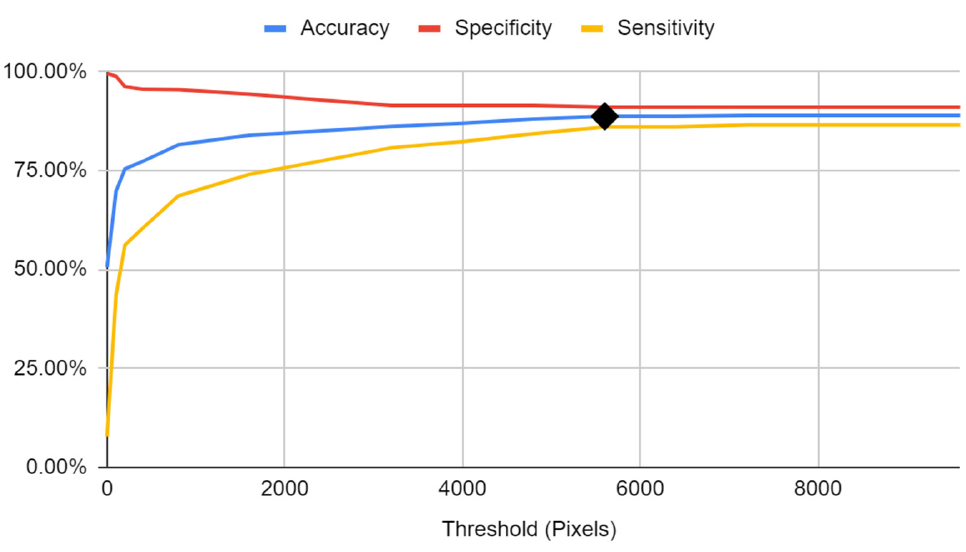
Figure 7. This graph is a visual representation of the information presented in Table 5, excluding the row for SVM results.